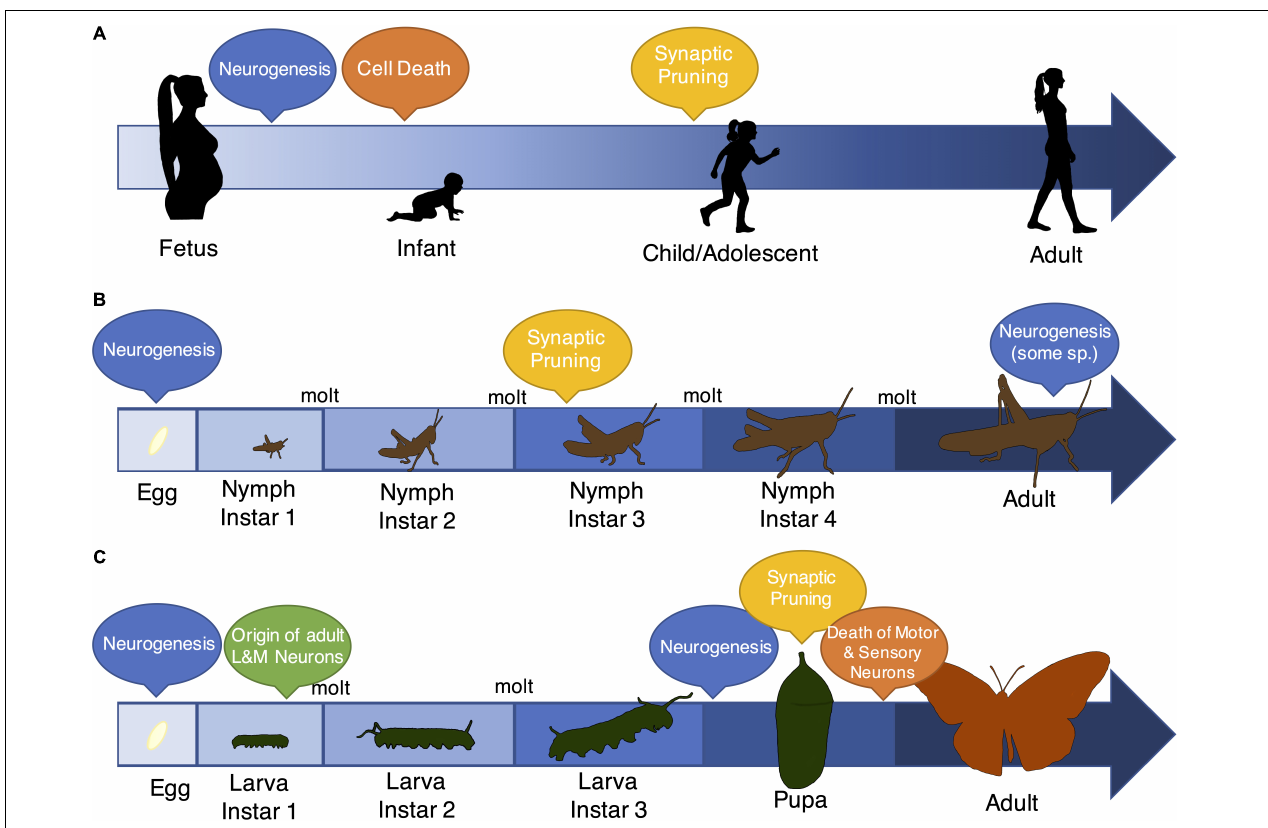
FIGURE 2 | Patterns of development, specifically the timing of neurobiological events, vary across vertebrates and insects. Although insects and vertebrates show remarkable overlap in the types of mechanisms that characterize brain development and entrain early-life experience (Watson, 1992; Pearson, 1993; Reh and Cagan, 1994; Salzberg and Bellen, 1996; Luo and O’Leary, 2005; Bello et al., 2008), the progression of early-life, and specifically the timing of events like neurogenesis, programmed cell death (“Cell Death”), and synaptic pruning, differs markedly across these groups. (A) Most vertebrates show gradual changes in body size and tissue morphology. In the brain, they experience massive neurogenesis early in life followed by cell death and pruning through adolescence and early adulthood (Watson et al., 2006). Notably, more limited neurogenesis also occurs during adulthood (Zhao et al., 2008). (B) Some insects also show a pattern of gradual development (called “incomplete metamorphosis”), where juvenile stages resemble the basic body plan of adults. However, these insects still shed their exoskeletons in order to grow, and as a result, they transition through distinct developmental stages. Relatively little is known about neurobiological events in these species, although there is evidence of extensive neurogenesis both prior to egg hatch and during adulthood (Cayre et al., 1994). There is also evidence for synaptic pruning dynamics that resemble vertebrate mechanisms (Lnenicka and Murphey, 1989). (C) The majority of insects ( ∼ 80% of species) show a pattern of complete metamorphosis, where life stages have distinct morphologies, and adult behaviors and body plans vastly differ from juveniles. Data from several representatives of this group again suggest multiple periods of neurogenesis, both early in life and during the pupal stage (Booker and Truman, 1987; Truman and Bate, 1988). Interestingly, the timing of neurogenesis and programmed cell death and the retention of neurons through the life stages is brain region (and thus, functionally) specific (Wegerhoff, 1999; Tissot and Stocker, 2000). For example, a small number of neurons responsible for learning and memory originate early in the larval period and persist through adulthood, but most motor and sensory neurons are completely remodeled during the pupal phase (Cantera et al.,